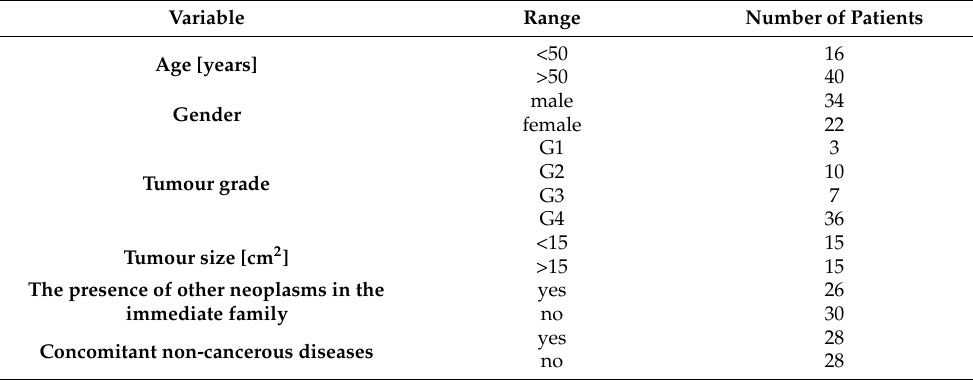
Table 1. Clinicopathological characteristics of patients.